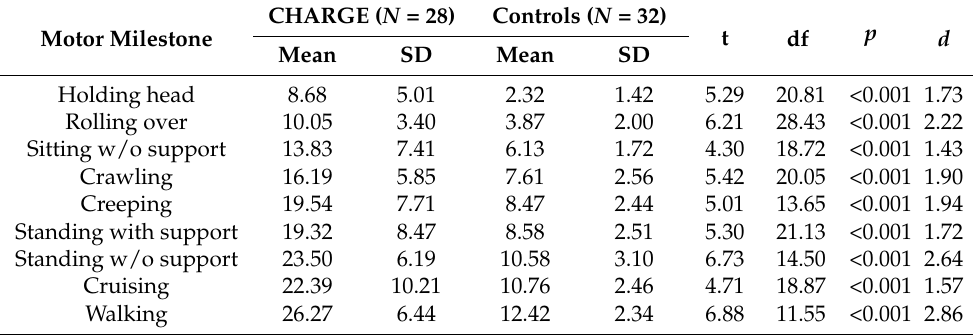
Table 4. Results of t -tests and means and standard deviations for age of motor milestone between children with and without CHARGE